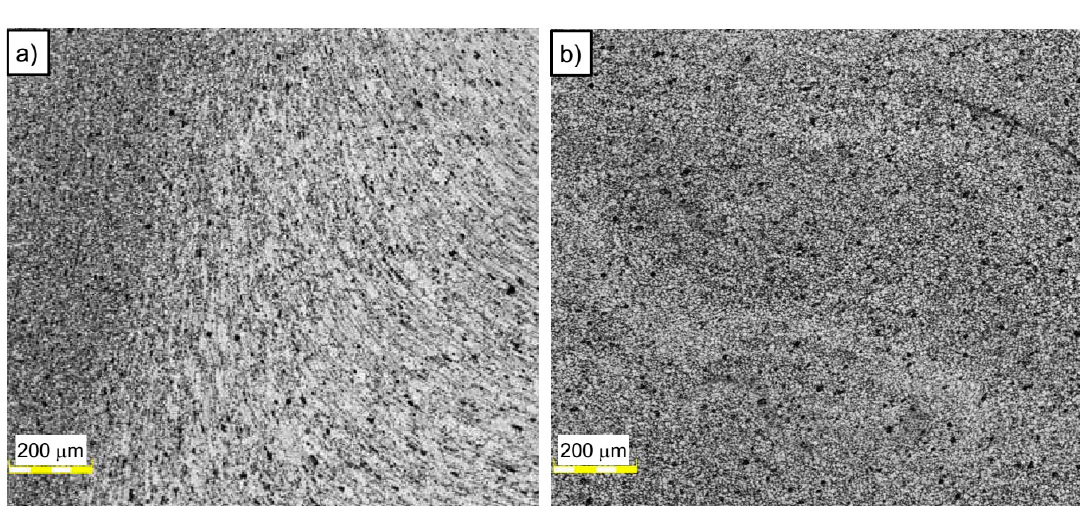
Figure 5. Microstructure of ( a ) boundary between thermomechanically affected zone (TMAZ) and SZ and ( b ) SZ in A5_5-2 sample.